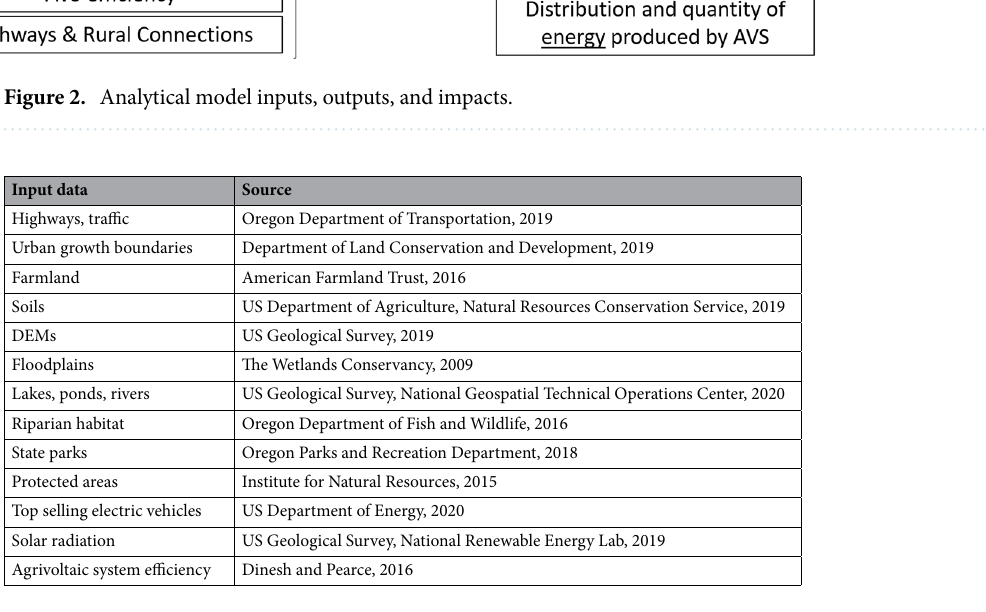
Table 2. Data inputs for analytical